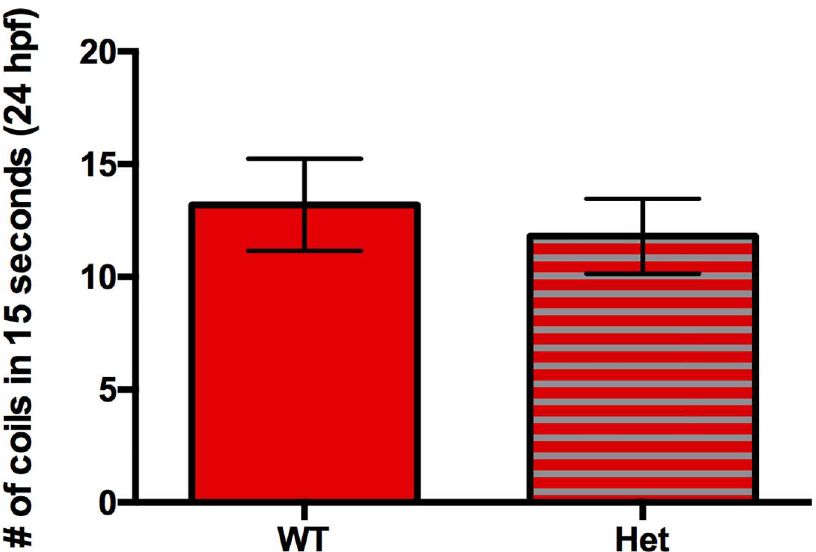
Fig 3. Heterozygous lama2 +/- embryos have no coiling deficiency. Heterozygous( lama2 +/- ) embryos do not displayany coilingdeficiencycomparedto their lama2 +/+ WT siblingsat 24 hpf after manualdechorionation (WT: 13.20 ± 2.037, n = 10; Het: 11.80 ± 1.654, n = 15; p = 0.5984).Bars representmean ±